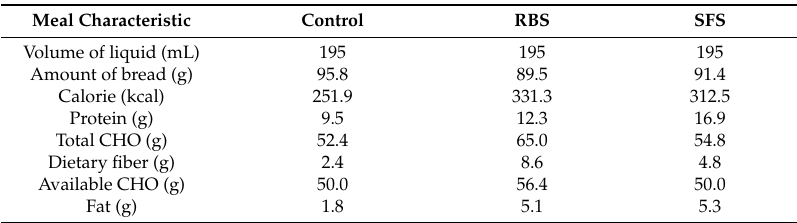
Table 1. Nutrient composition and portion size